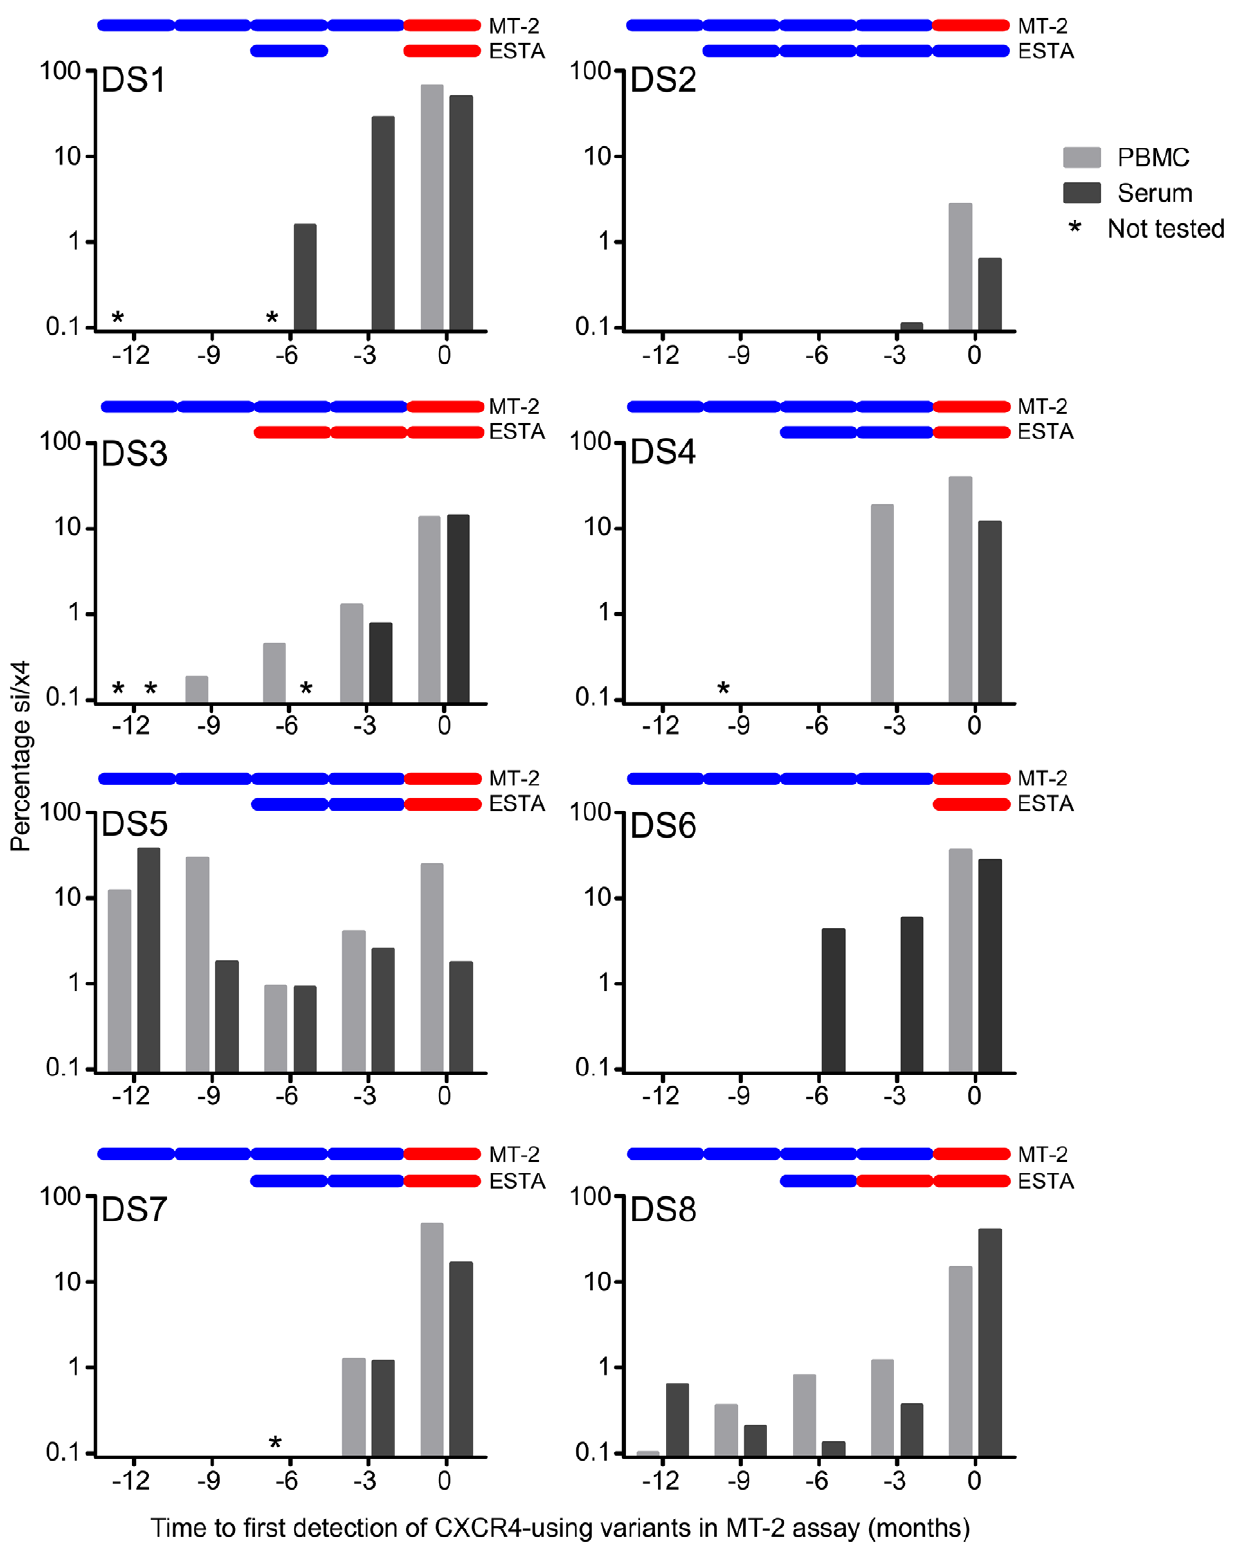
Figure 1. Detection of predicted CXCR4-using variants that emerge during natural HIV-1 infection using deep sequencing. For each participant, the percentage si/x4 sequences in PBMC (light grey bars) and serum (dark grey bars) at time points up to one year before the first phenotypic detection of CXCR4-using variants in the MT-2 assay are shown. Samples that have not been sequenced are indicated with an asterisk. In the top of each graph, the results of the MT-2 assay and the enhanced-sensitivity Trofile assay (ESTA) are given: a blue bar indicates NSI or R5, respectively, while a red bar indicates SI or D/M, respectively.